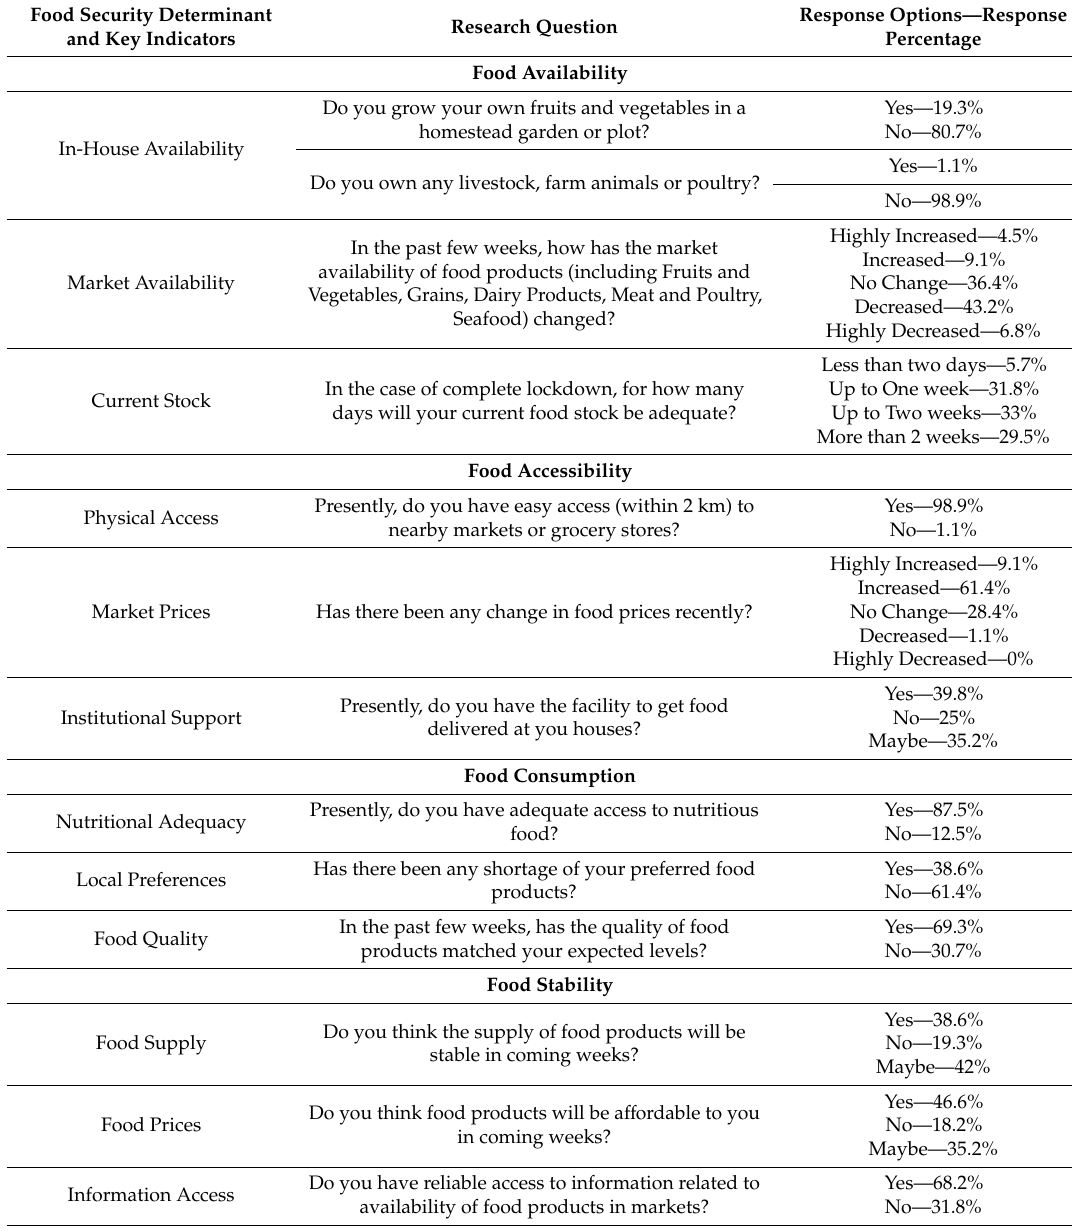
Table 4. Perceived household food security of survey respondents during the peak-building